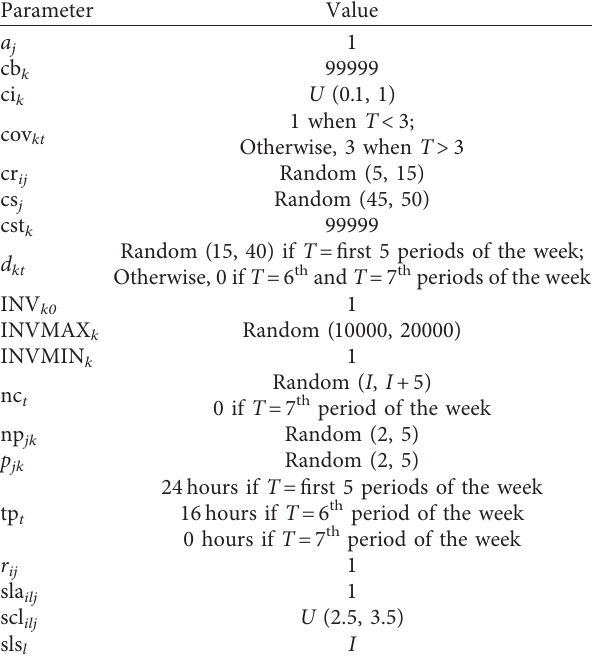
Table 4: Generation of value for data parameters.